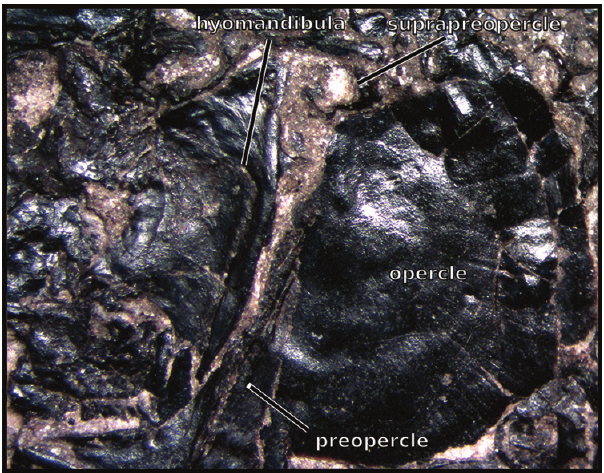
Fig. 7 . Opercular region of Dastilbe moraesi (CPUFMT 745, 16.3 mm TFL) in lateral view, anterior to left: Synapomorphies of Chanidae observed are: opercular bone is expanded, at least one-third of the head length; and suprapreopercular bone is present as a relatively large, flat bone.